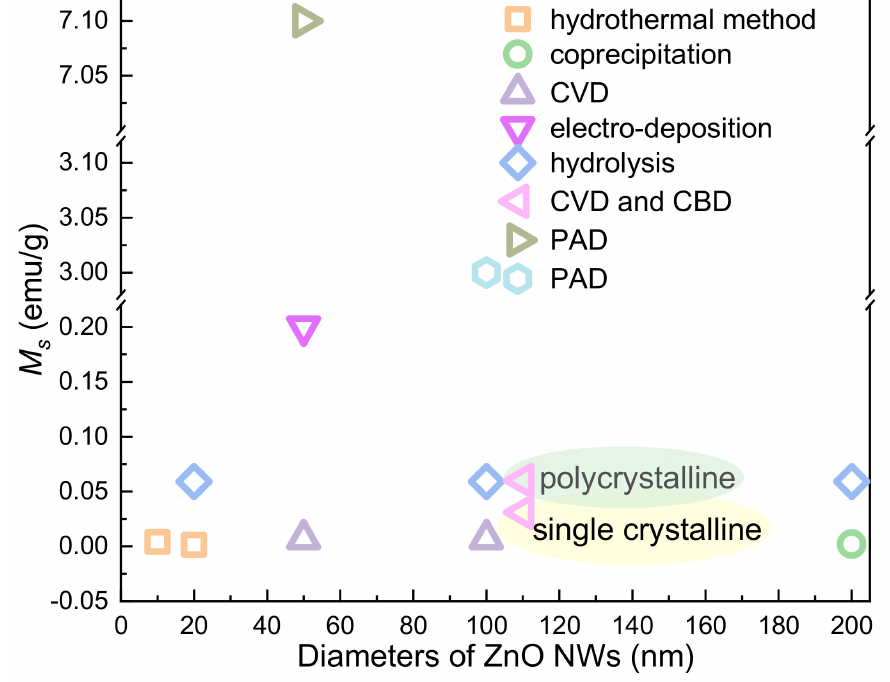
Figure 7. The size-dependent RTFM in ZnO